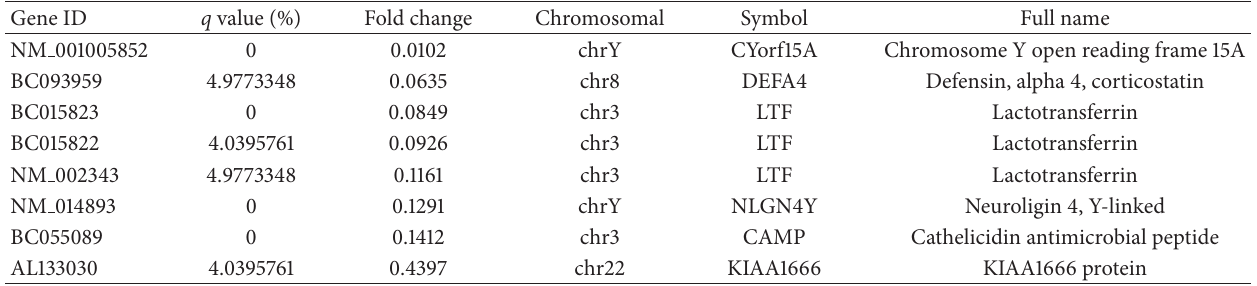
Figure 5: Expression levels of CAMP, LTF, and DEFA4 measured by qPCR in B cells from SLE patients. B cells were purified from eight male SLE patients and eight female SLE patients. Then the expression of CAMP, LTF, and DEFA4 was checked by qPCR. The data are presented as relative expression following normalization. Asterisks represent significant difference to the male ( ∗ 𝑃 < 0.05 ). NS: 𝑃 > 0.05 . Table 6: Eight down-regulated expression genes in SLE females versus SLE males, which have nonsignificant difference between healthy females and healthy